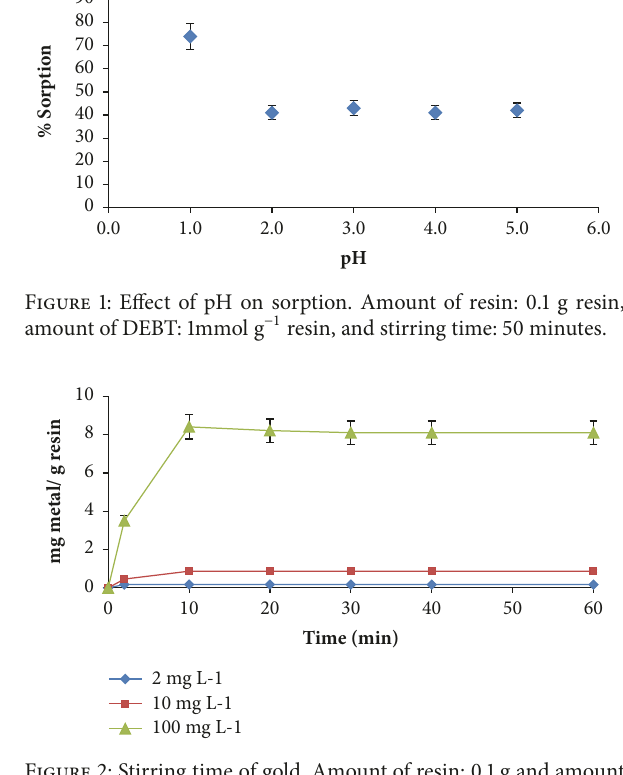
Figure 2: Stirring time of gold. Amount of resin: 0.1 g and amount of DEBT: 1 mmol g −1